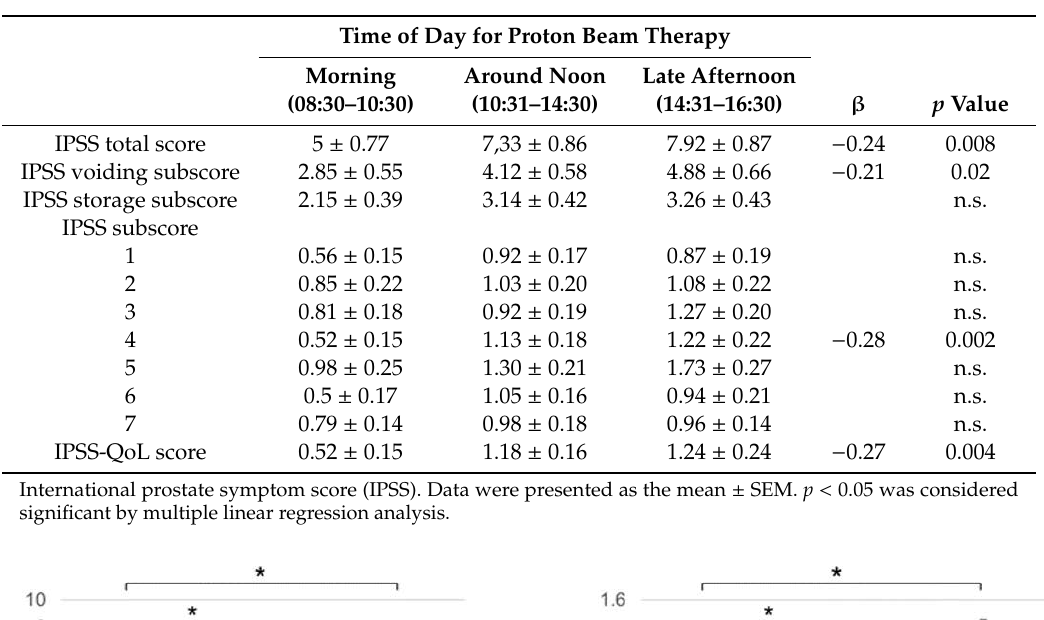
Table 2. Changes in IPSS compared with time of day for radiation.